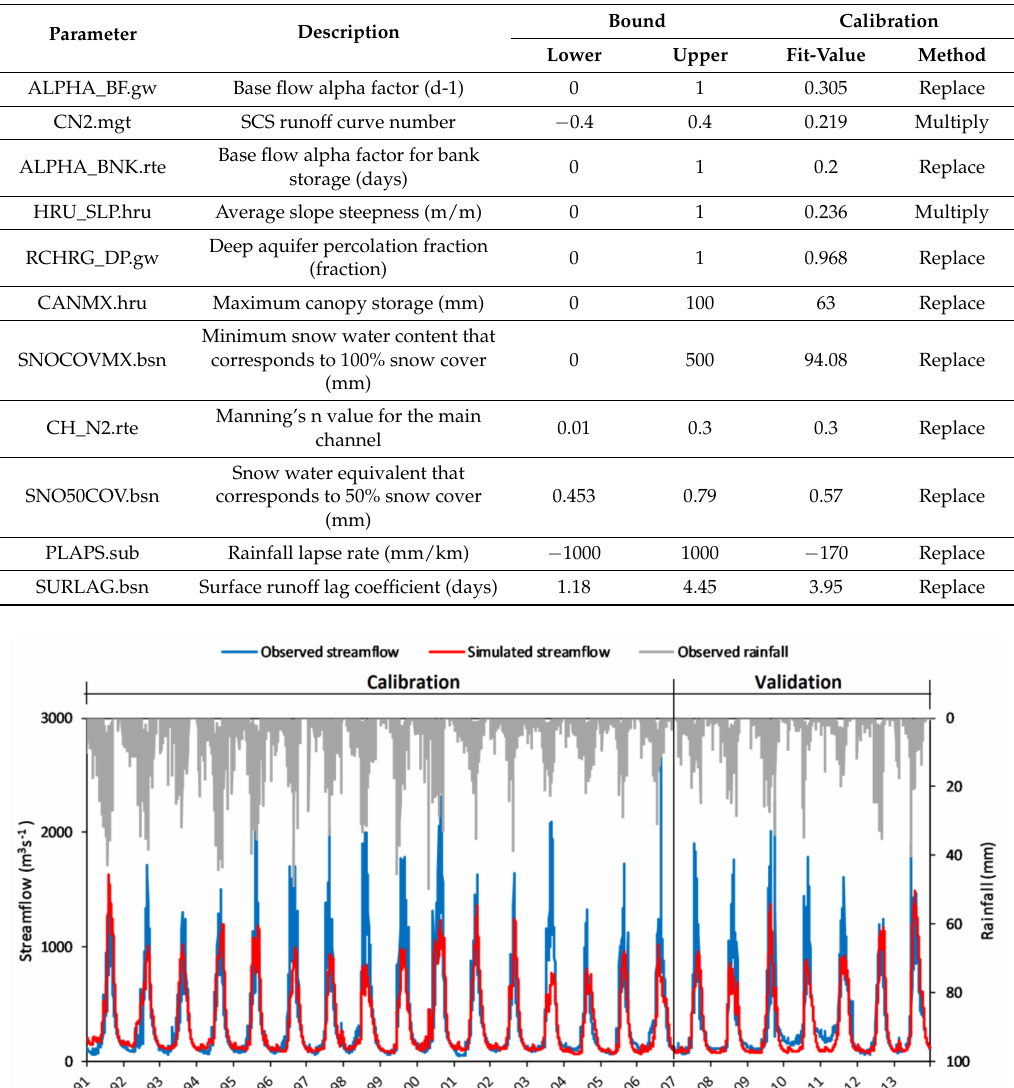
Table 5. Most sensitive parameters given by the SWAT-CUP.